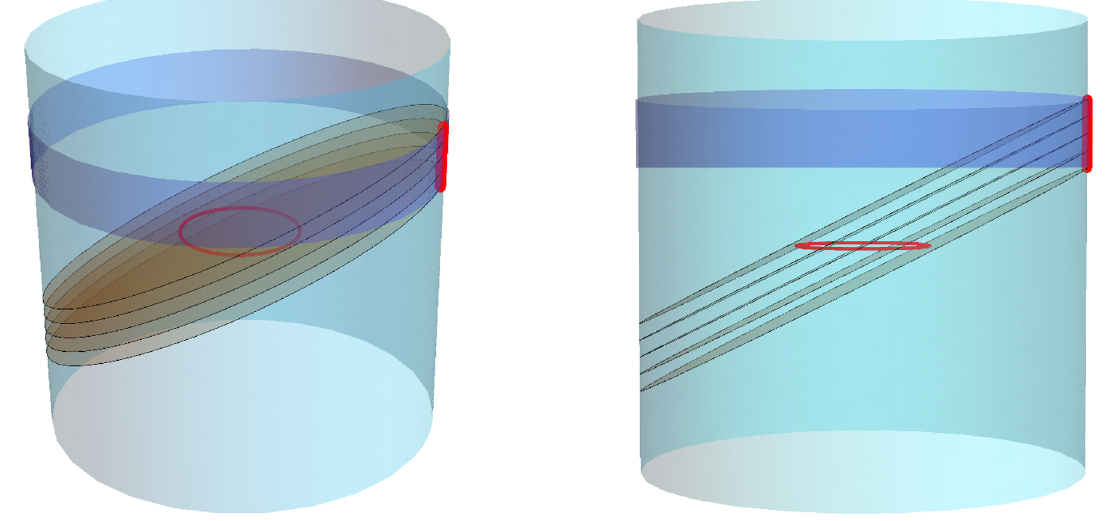
Figure 6 . The integration region in (4.8) comprises null planes, which intersect the bulk curve. The tops of those null planes fall between the loci (4.5) and (4.6) and comprise points, which are neither entirely spacelike nor entirely timelike-separated from the whole